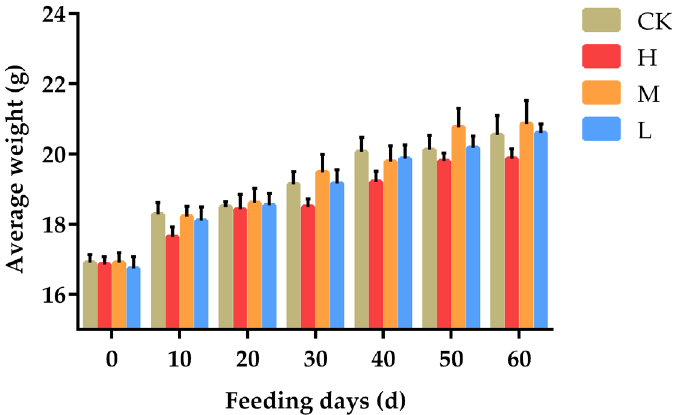
Figure 2. Effects of ALE on body weight of mice. Note : CK: 50 μL 0.9% NaCl; H: 50 μL 300 mg/kg ALE; M: 50 μL 150 mg/kg ALE; L: 50 μL 75 mg/kg.